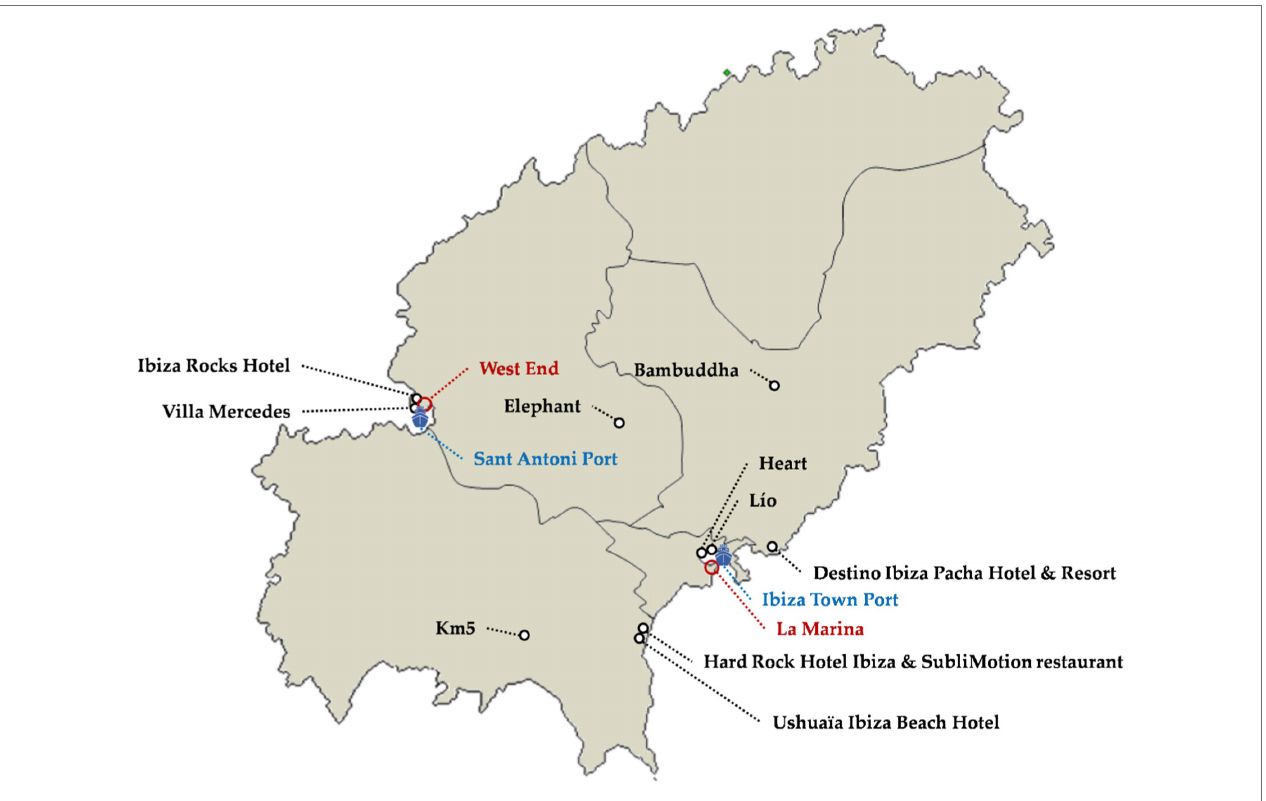
FIGURE 5 | Other music and nightlife options. Source: own